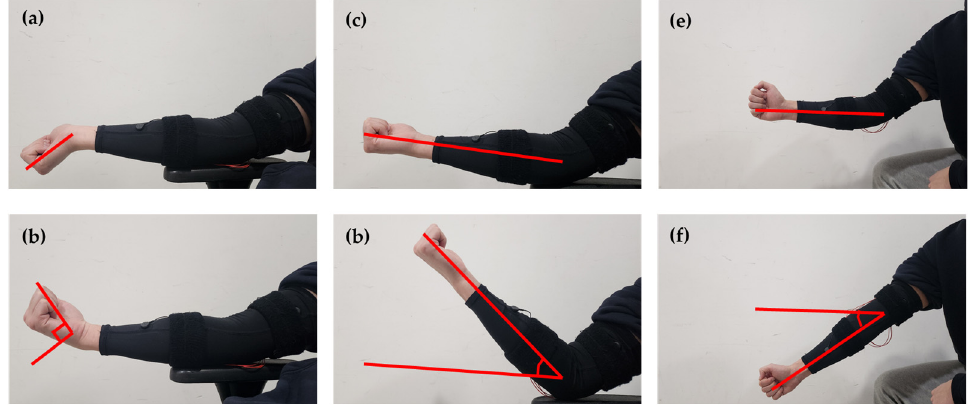
Figure 5. Perform the workout: ( a ) Wrist Curl (contraction), ( b ) Wrist Curl (extension), ( c ) Biceps Curl (contraction), ( d ) Biceps Curl (extension), ( e ) Dumbbell Kickback (extension), ( f ) Dumbbell Kickback (contraction).